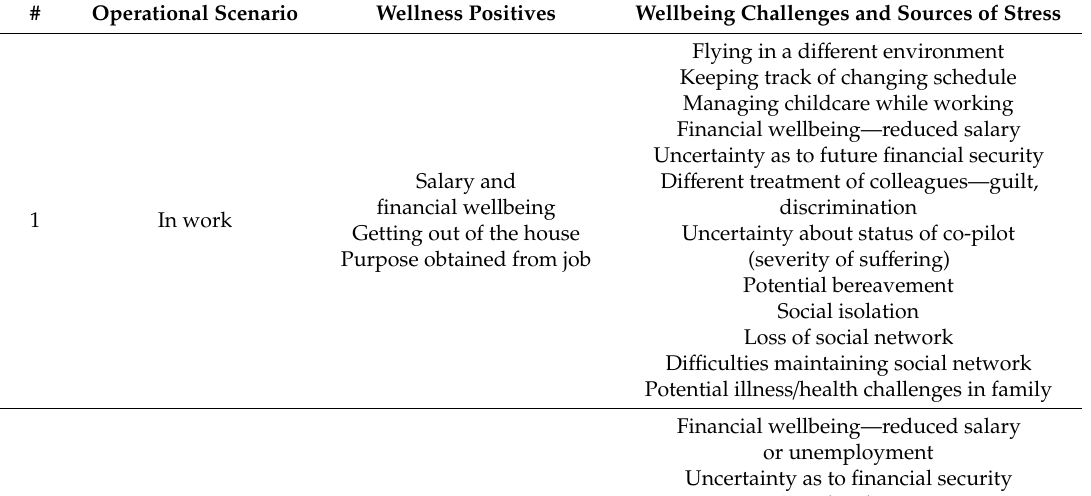
Table A3. COVID-19, pilot wellness positives and